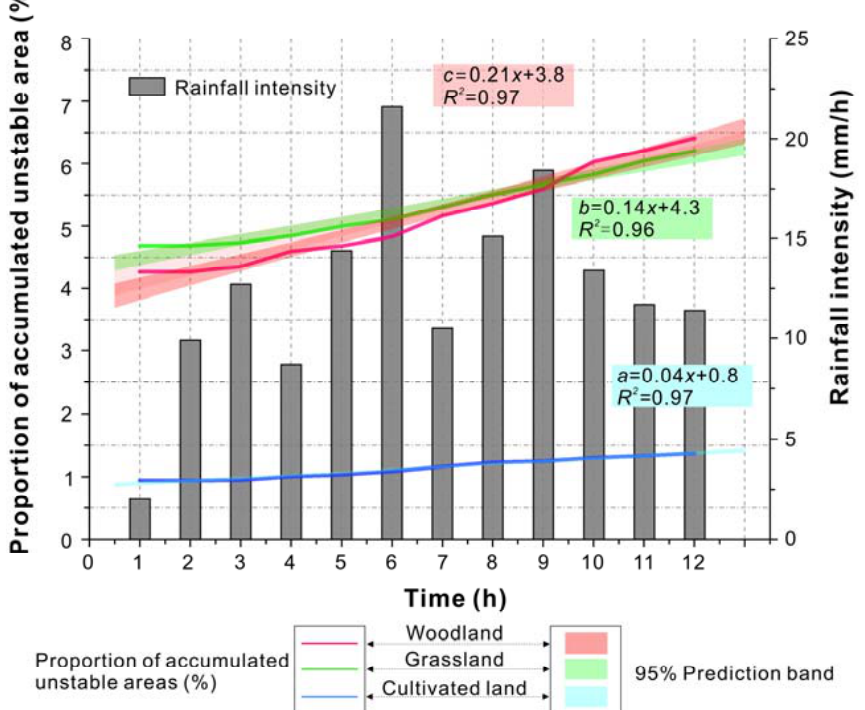
Figure 6. Relationship between the proportion of the unstable slope area and the amount of rainfall. The solid line shows the change in the soil stability under the different types of vegetation, and the strip is the total prediction band, which shows the fitting performance.